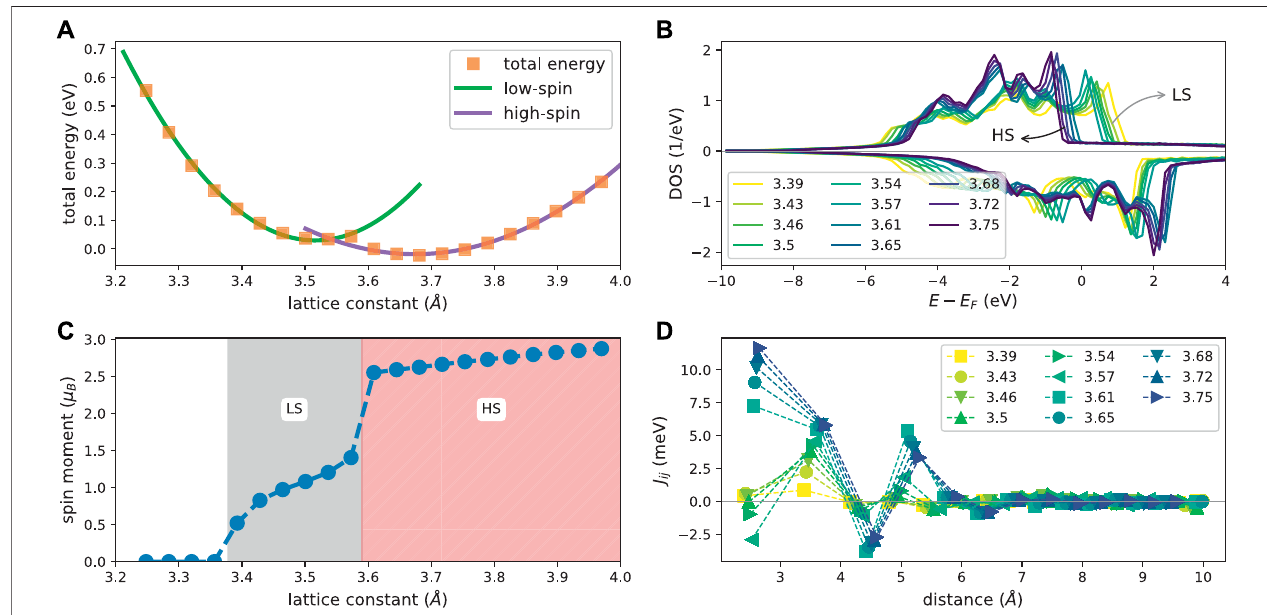
FIGURE5| ResultsoftheDFTcalculationsfor γ – Fe.Totalenergyasafunctionofthelatticeconstant (A) wherethegreenandvioletlinesshowparabolic fi tstolow- spin ( a lat < 3 . 6 (cid:2) A ) and high-spin ( a lat ≥ 3 . 6 (cid:2) A ) states. (B) Corresponding density of states (value in the legend indicates the lattice constant) which clearly separates into low-spin (LS) with smaller exchange splitting and high-spin (HS) states with larger exchange splitting. Note that the positive (negative) values of the DOS indicate the majority (minority) spin channels. (C) Spin moment as a function of the lattice constant where the transition from non-magnetic ( fi rst four data points) over the low-spin state to the high-spin state is evident. (D) Resulting exchange coupling constants ( J ij ) as a function of the pairwise distance between the Fe atoms in γ – Fe (the lattice constant is given in the legend).